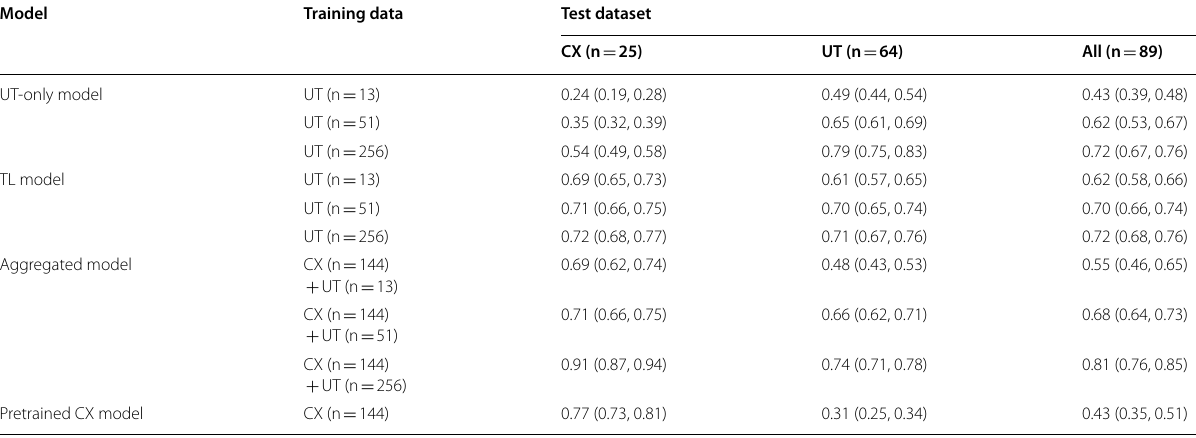
Data are presented in mean with parentheses for 95% CI CX Cervical dataset, UT Uterine